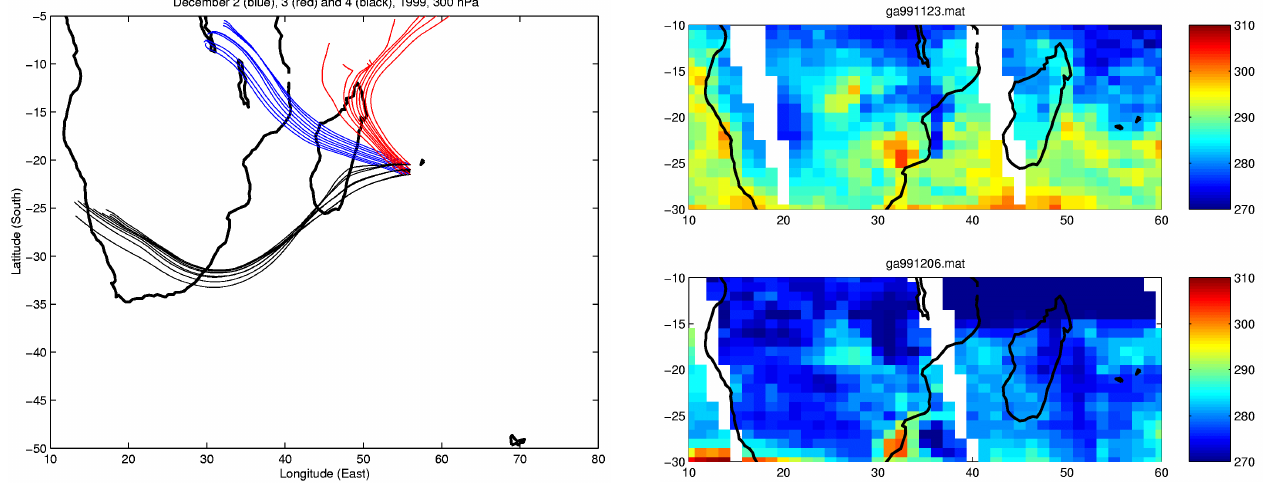
Fig. 10. Distribution of total ozone as measured by the TOMS in- Figure 9 Fig. 9. As Fig. 8, cluster back trajectories for 3 days ending on 2 strument for 23 November 1999 (top) and 6 December 1999 (bot- December (blue), 3 (red) and 4 (black) 1999, over Reunion Island, tom). Data provided by web site at at 300hPa level, corresponding approximately to 9km altitude.